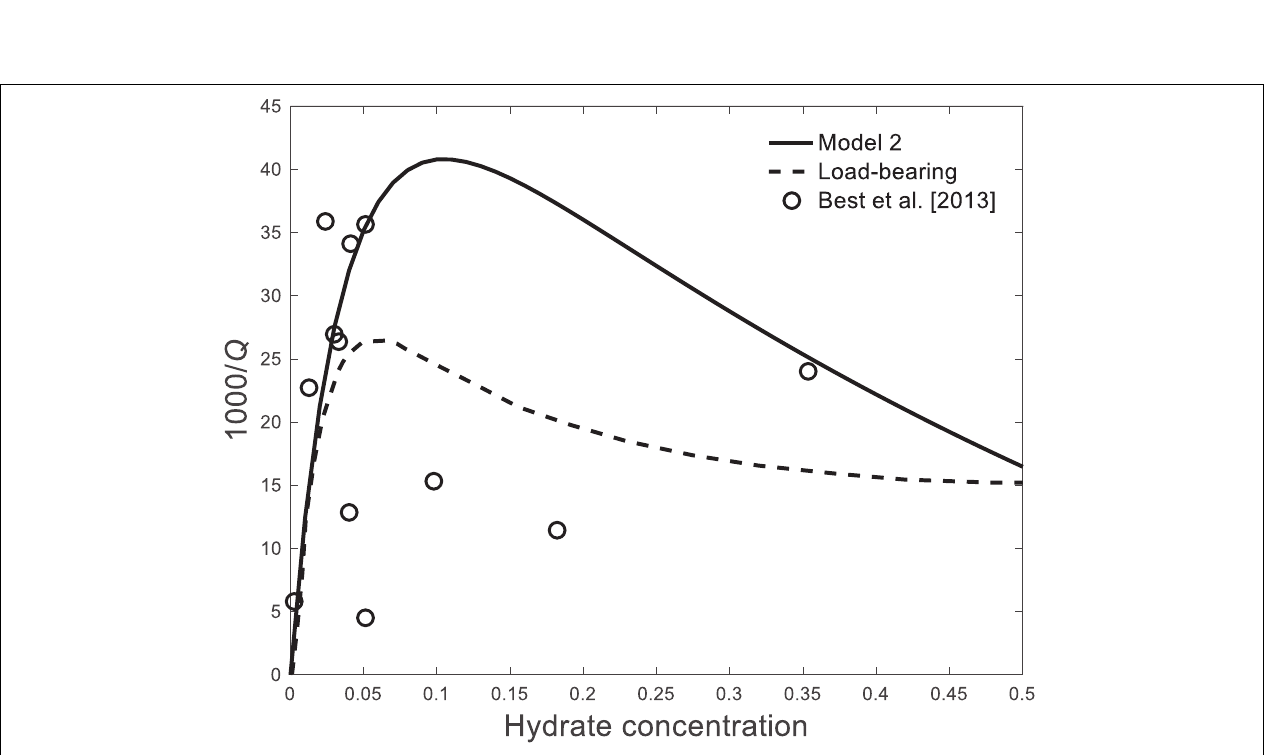
FIGURE 14 | Model 2. Dissipation factor as a function of hydrate concentration. The frequency is around 200 Hz. The load-bearing model curve and experimental data (circles) are taken from Best et al. (2013).